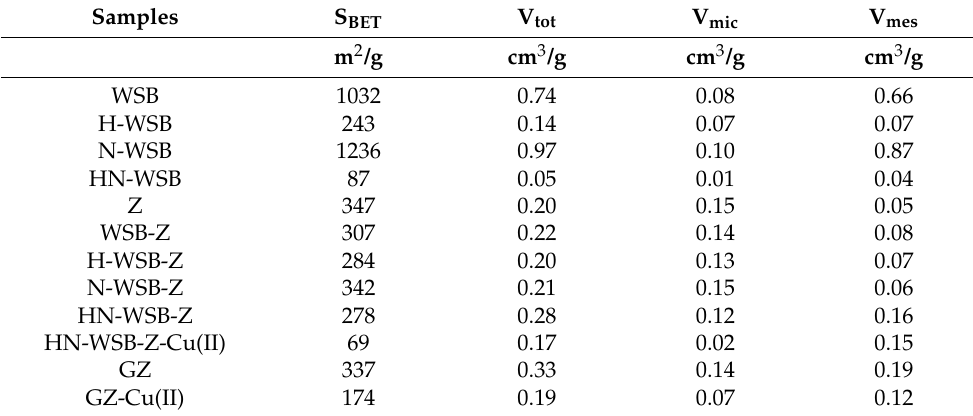
Table 1. Textural properties of different samples.